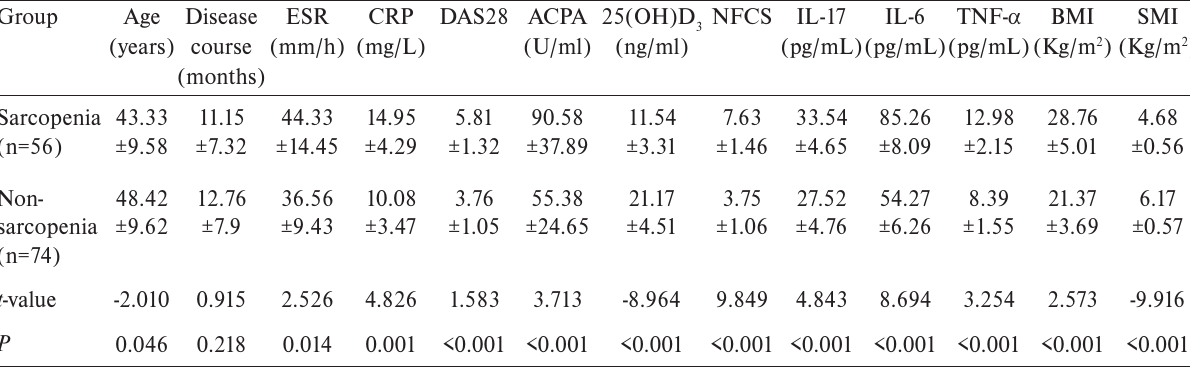
Table 2. Comparison of clinical data of sarcopenia group and non-sarcopenia group.